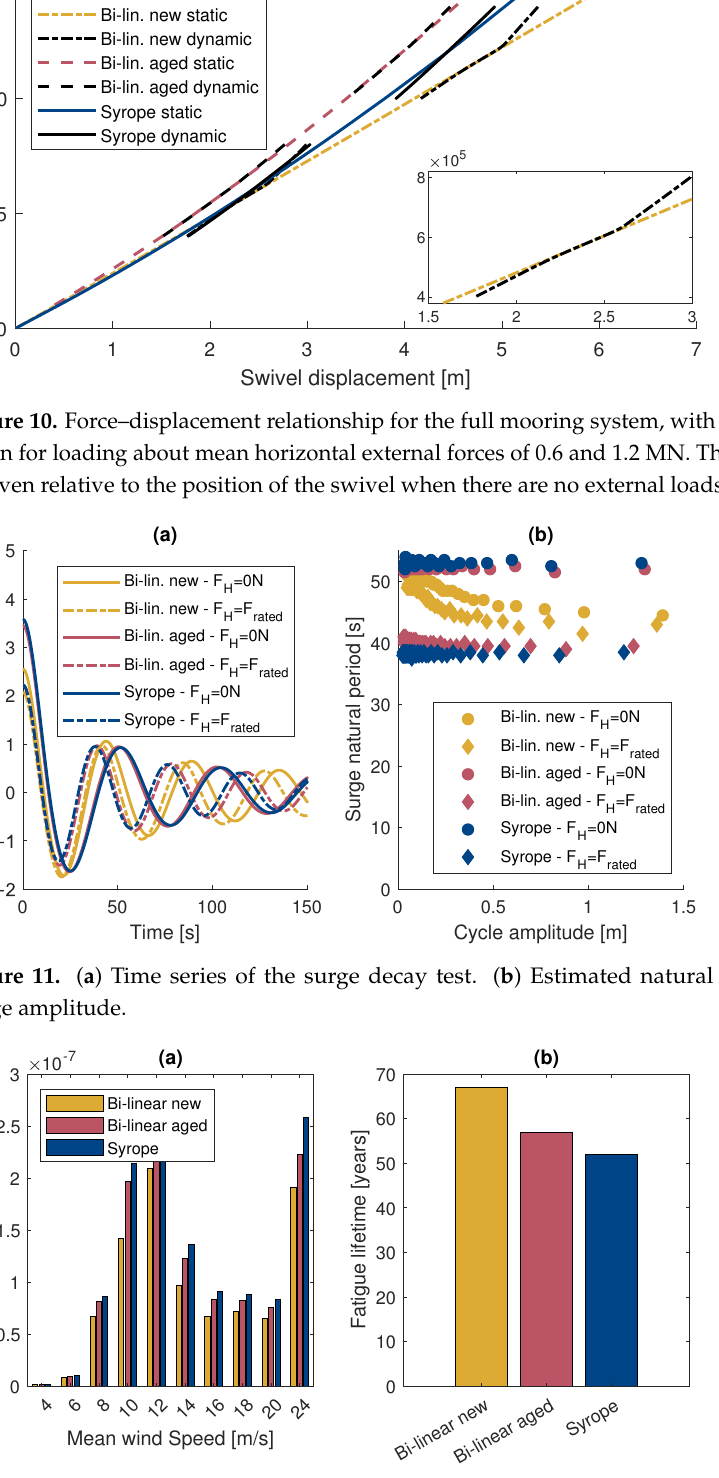
Figure 12. ( a ) 1-h fatigue damage in the upwind fairlead chain, multiplied by probability of occur- rence. ( b ) Fatigue lifetime in the fairlead chain if the environmental loads are equally probably to arrive parallel to the three mooring line